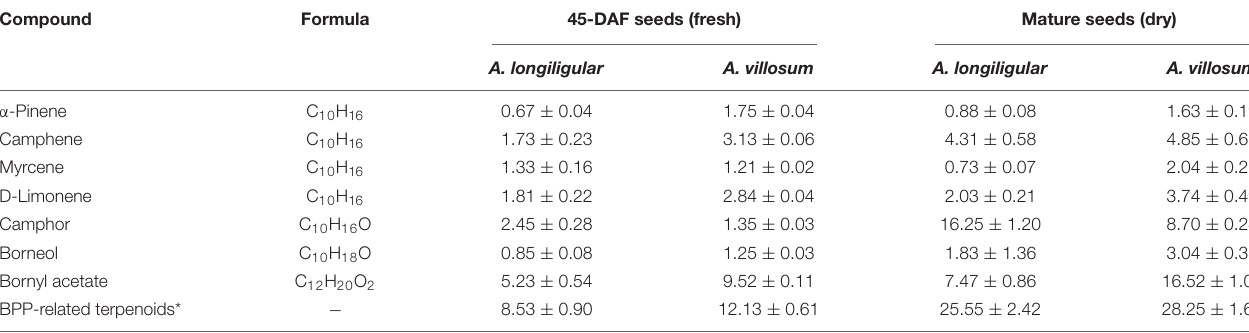
TABLE 1 | Comparison of main monoterpenoid contents ( µ g/mg) in seeds of A. logiligulare and A. villosum. Compound